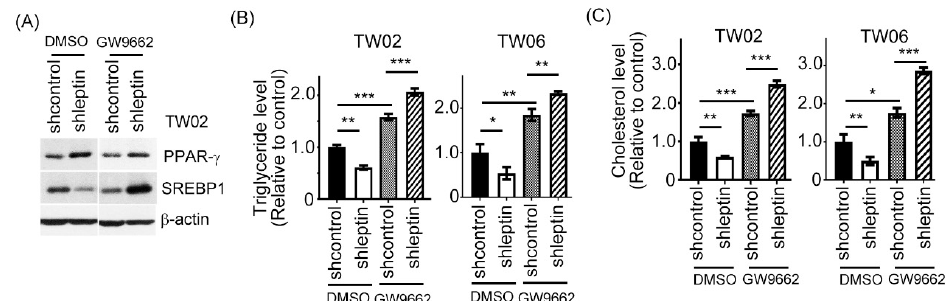
Figure 3. Leptin deficiency decreases SREBP1 via upregulation of PPAR- γ in NPC cells. ( A ) Western blot analysis of PPAR- γ and SREBP1 in leptin-depleted NPC cells in the absence or presence of GW9662. ( B , C ) The levels of TG and cholesterol in the indicated NPC cells with GW9662 treatment were measured. All data were obtained from three independent experiments. Data are presented as the mean ± SD. *: p < 0.05; **: p < 0.01; ***: p < 0.001.